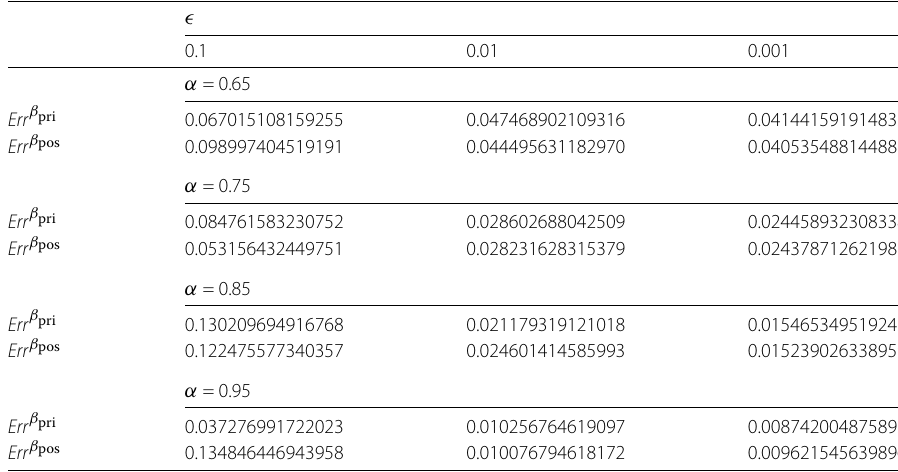
Table 1 Error estimates between the exact and regularized solutions for τ = 1.6, α ∈ { 0.65,0.75,0.85,0.95 }